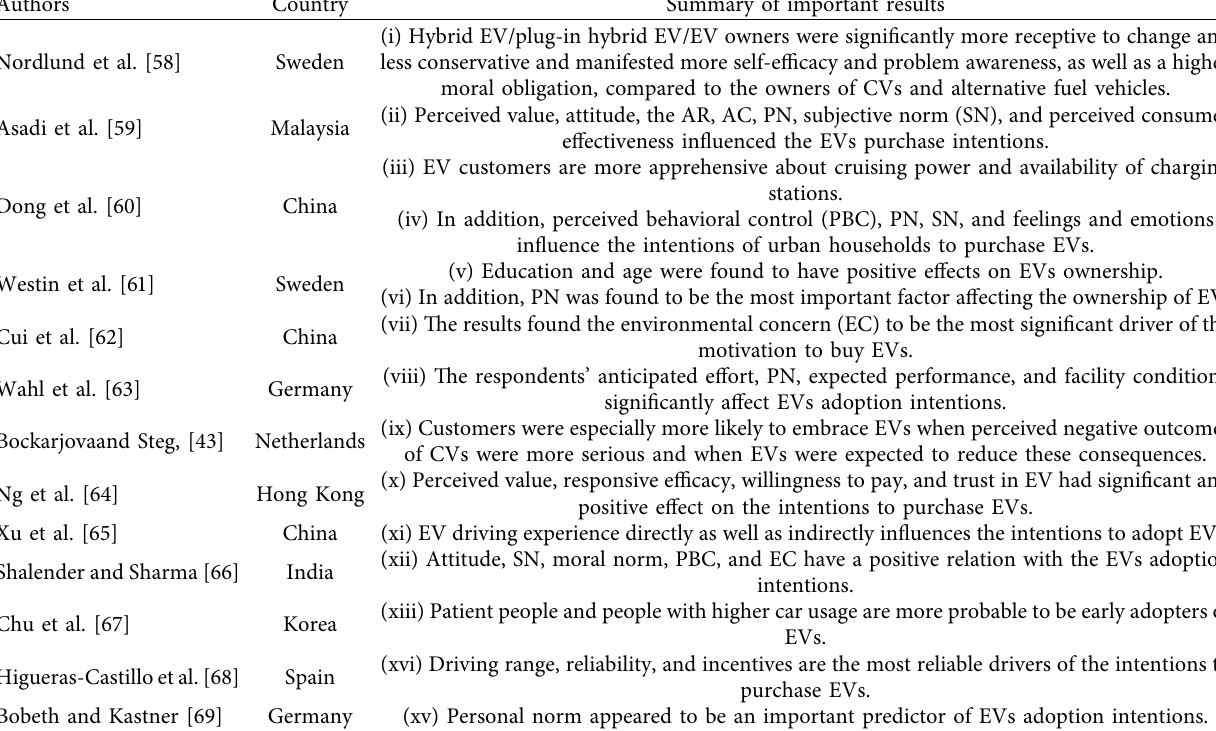
Table 1: A summary of relevant